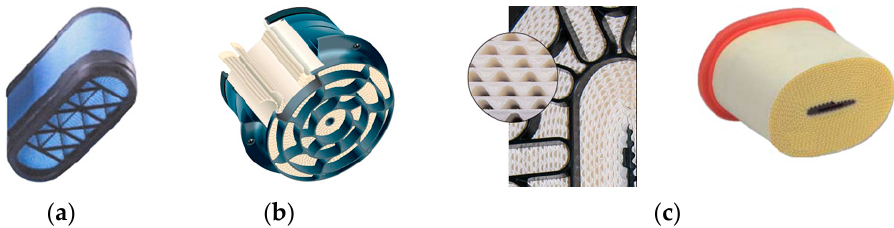
Figure 9. Filter cartridges made with modern technologies: ( a ) traditional PowerCore (Donaldson) [41], ( b ) Channel Flow (Baldwin) [43], ( c ) CompacPlus (Mann + Hummel) [44]. The drawing was made by the author based on the data in [41,43,44].